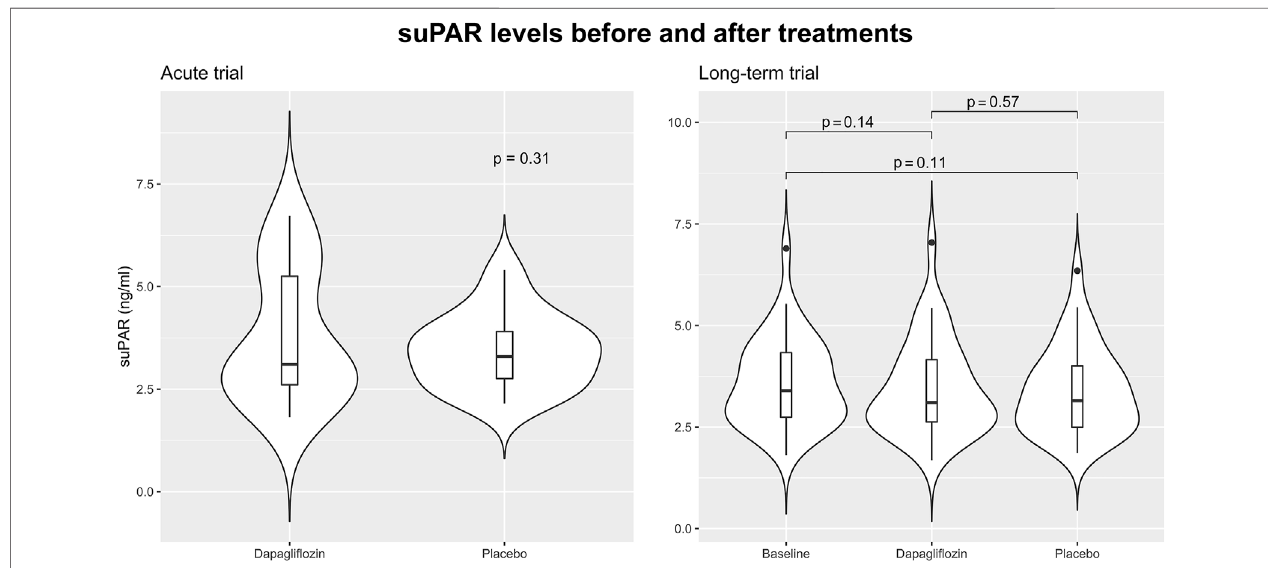
FIGURE 1 | Violin plots visualizing the distribution of soluble urokinase plasminogen activator receptor (suPAR) in the acute and long-term trials. In the acute trial suPAR levels 12 h after treatment with a single dose of 50 mg dapagli fl ozin are shown. In the long-term trial suPAR level is shown at baseline, after 12 weeks treatment withdapagli fl ozin10 mgdaily,andafter12 weekstreatmentwithplacebo.BaselinedataofsuPARlevelwasnotavailableintheacutetrial.Allcomparisonsareperformed using paired t-tests.